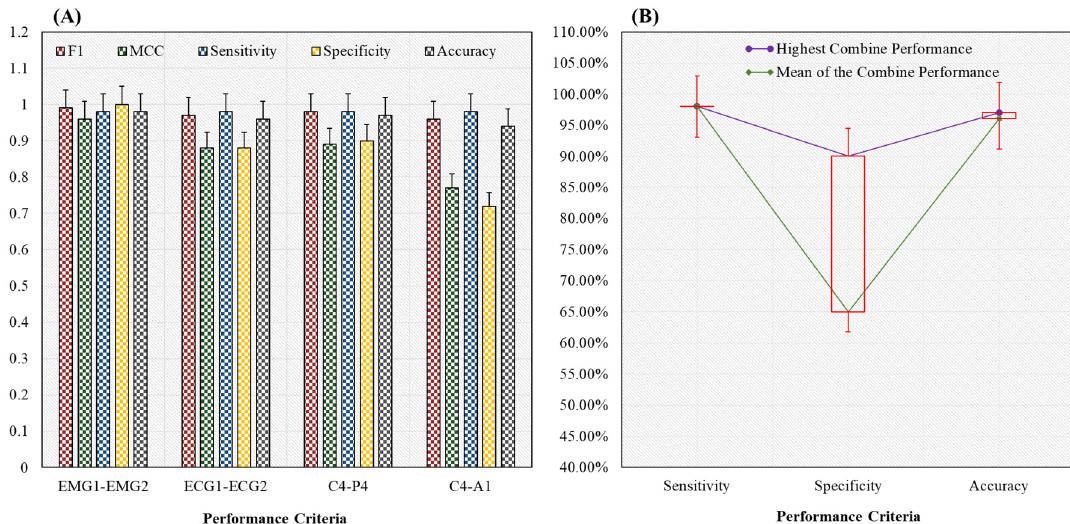
(w and REM) classification using the novel 20-fold HML classifier. ( A ) Comparison between all channels such as EMG1-EMG2, ECG1, ECG2, C4-P4, and C4-A1 channels of the sleep stages classification. In addition, ( B ) highest and mean performance of the combined classification. The C4-P4 channel of the